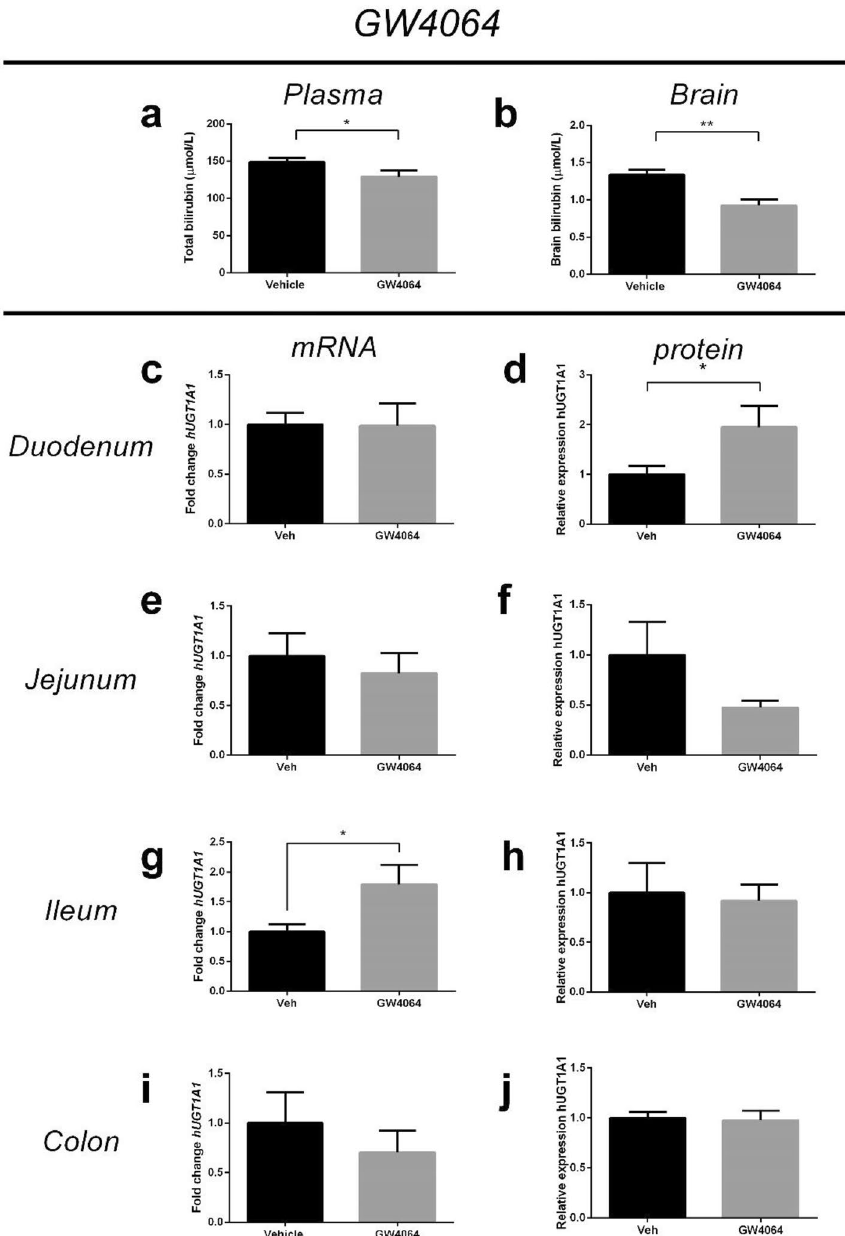
Figure 4. Effect of GW4064 on plasma and brain bilirubin and intestinal expression of hUGT1A1 in neonatal hUGT1*1 mice. Effect of GW4064 treatment (50 mg/kg/day) (n = 6) on ( a ) Total plasma bilirubin level; ( b ) Brain bilirubin levels; ( c , d ) mRNA and protein expression of hUGT1A1 in duodenum; and mRNA and protein expression of hUGT1A1 in ( e , f ) jejunum; ( g , h ) ileum and ( i , j )